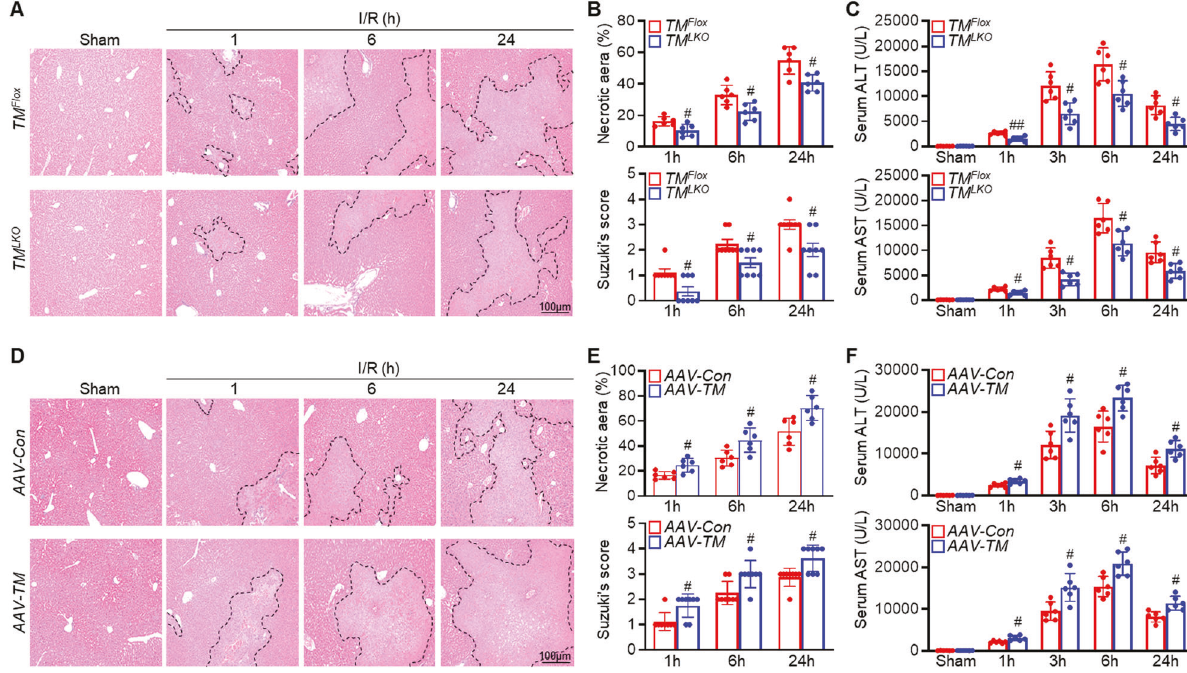
Fig. 2 Hepatocyte-speci fi c TMEM16A de fi ciency protects against hepatic I/R injury. A Representative H&E staining and B quantitation of necrotic areas (upper) and Suzuki histological scores (bottom) of liver tissues from TM Flox and TM LKO mice subjected to 90 min of hepatic ischemia followed by reperfusion for the indicated periods ( n = 6 – 8). # P < 0.05 versus corresponding TM Flox . C Serum ALT and AST levels in TM Flox and TM LKO mice from indicated groups ( n = 6). # P < 0.05, ## P < 0.01 versus corresponding TM Flox . D Representative H&E staining of liver sections from AAV-Con- or AAV-TM -treated mice subjected to sham operation or 90 min of hepatic ischemia followed by reperfusion for indicated periods. E Quanti fi cation of necrotic areas (upper) and Suzuki histological scores (bottom) ( n = 6 – 8). # P < 0.05 versus corresponding AAV-Con . F Serum ALT and AST levels in AAV-Con- and AAV-TM- treated mice from the indicated groups ( n = 6). # P < 0.05 versus corresponding AAV-Con . Data were presented as the mean ±